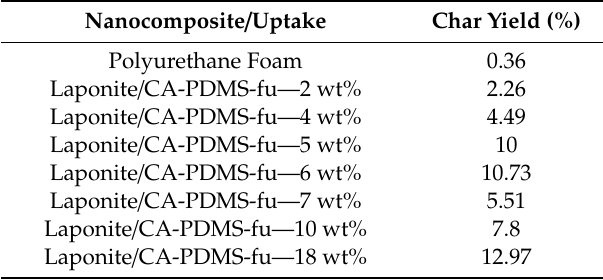
Table 2. Char yield percentage of the coated PUF for different uptake.